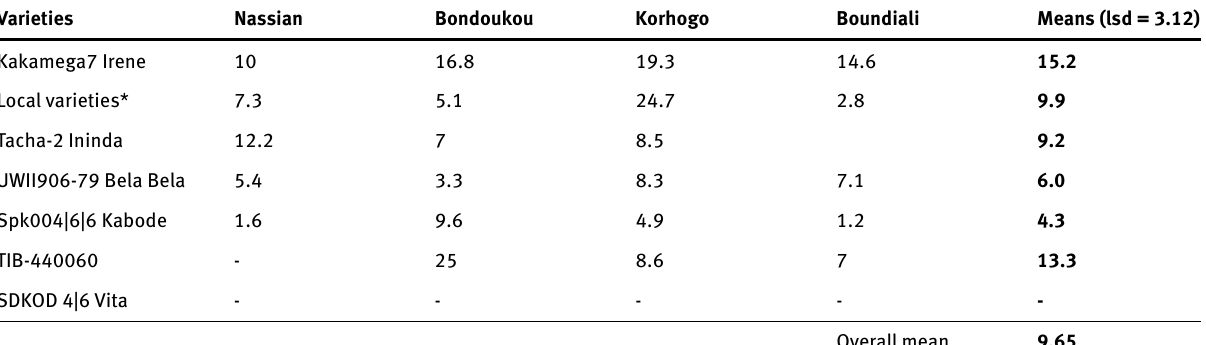
Table 4 : Yields (t/ha) recorded with varieties in different localities Varieties Nassian Bondoukou Korhogo Means (lsd = 3.12)